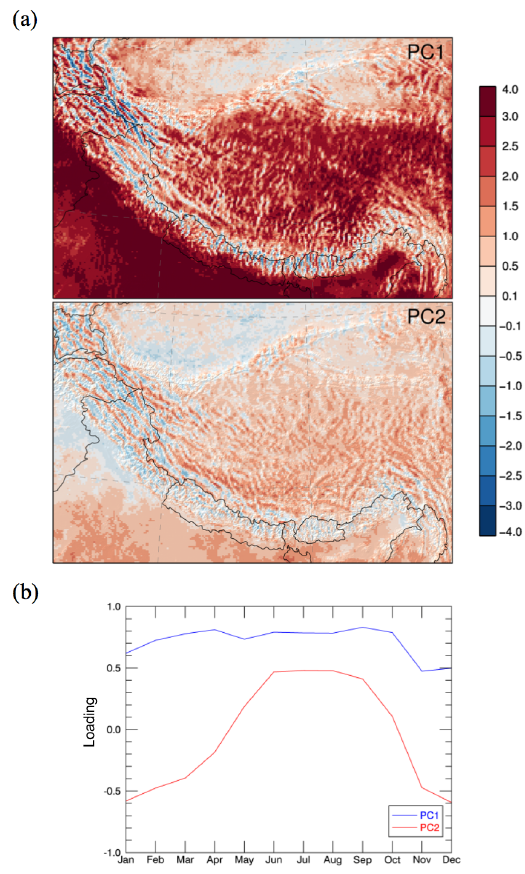
Figure 11. Scores of first two principal components PC1 and PC2 for the correlation between atmospheric water transport (AWT) and precipitation (a) (positive values are denoted in red, while negative values are denoted in blue) and the monthly loadings (b) for both